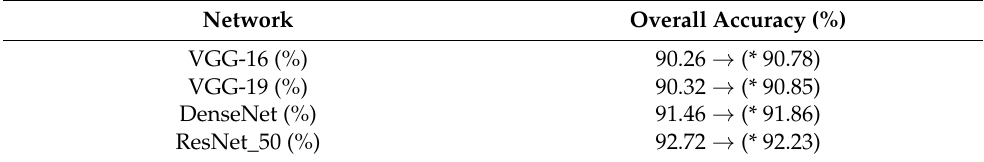
Table 3. Experimental results of different networks for different visibility ranges .